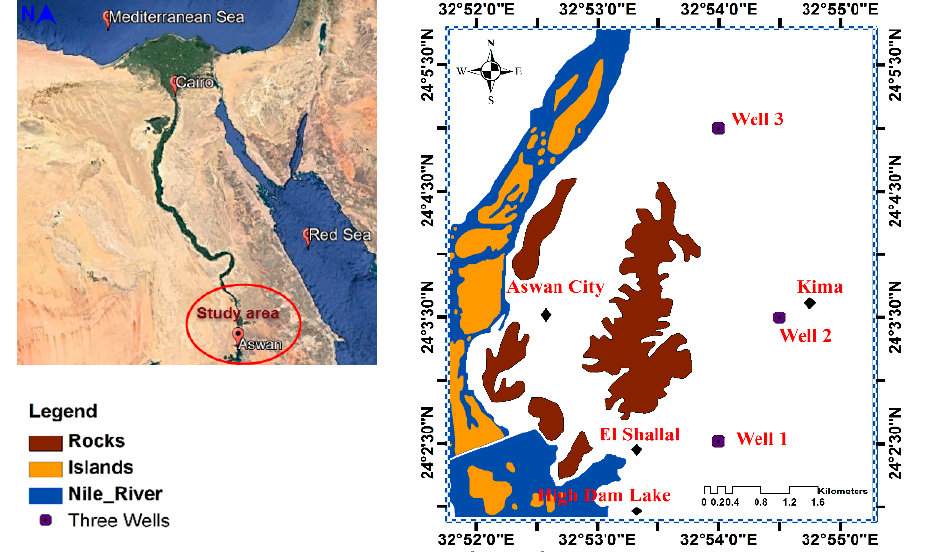
Figure 4. The study area location map.